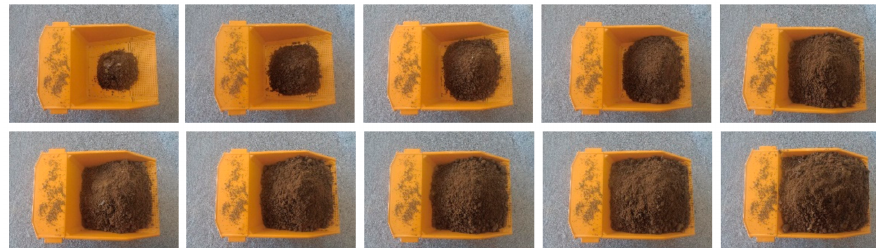
Figure 5. Part of the test set images.